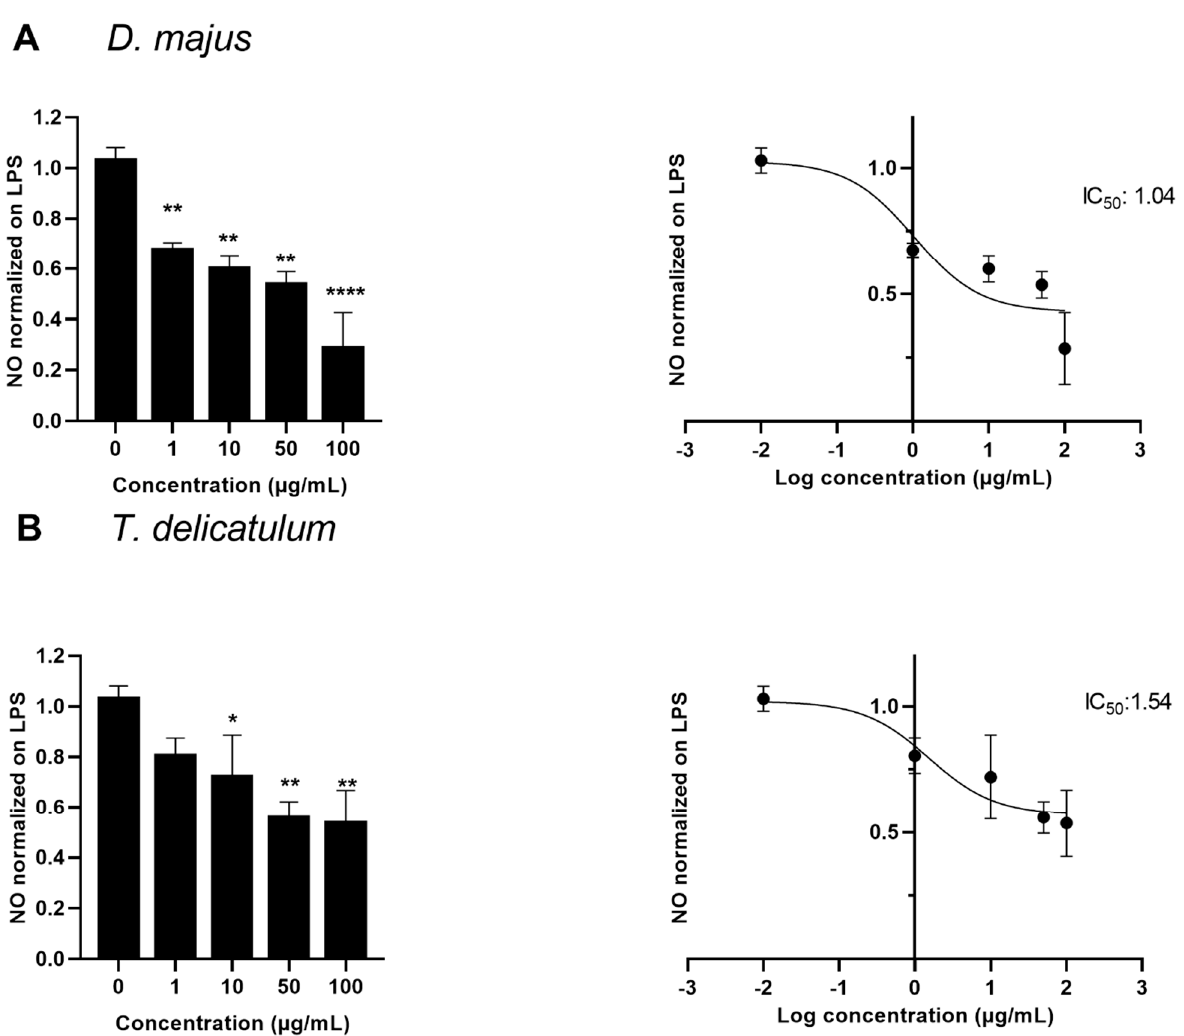
Figure 4. Dose-response effect and IC 50 values of 70% ethanol extract from ( A ) D. majus and ( B ) T. del- icatulum , on LPS-induced NO in RAW264.7 cells. Data represent mean ± standard deviation (n = 2–3 of cells treated with extracts) and values are normalized on LPS (1 ng/mL). * p < 0.05, ** p < 0.01, **** p < 0.0001 indicate significant differences compared to the